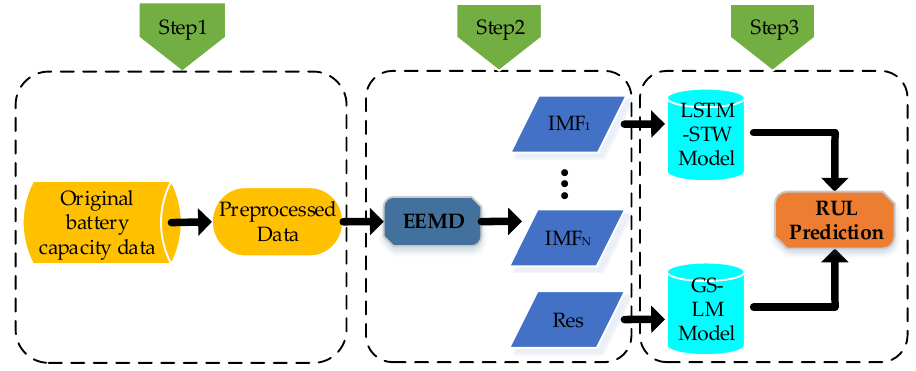
Figure 1. The structure of battery RUL prediction based on LSTM-STW-GS-LM and EEMD.